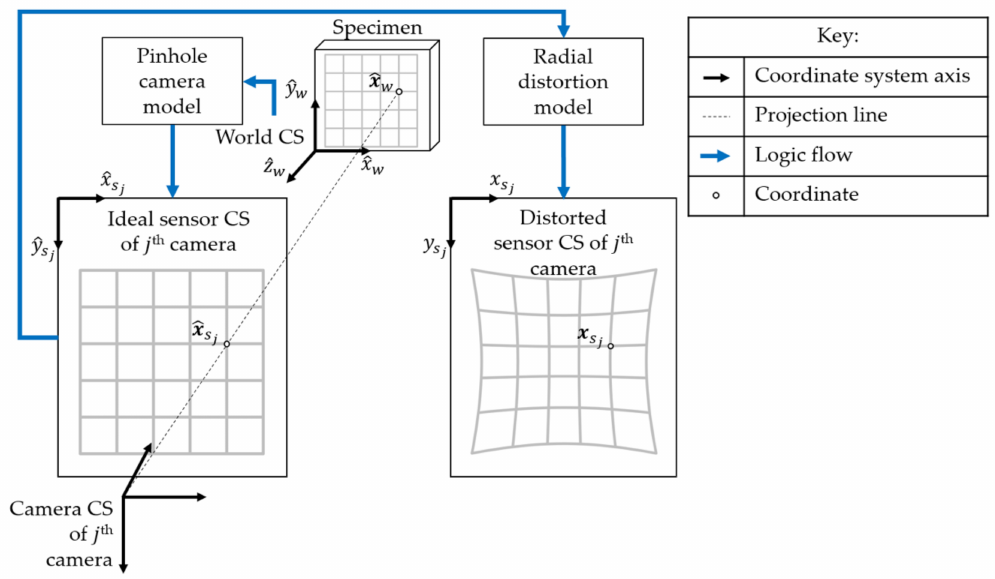
Figure 1. Schematic diagram of coordinate systems employed by the camera model. K j is only dependent on the camera system and does not change if the camera position changes. In contrast, V j depends on the relative position and orientation between the camera and the world